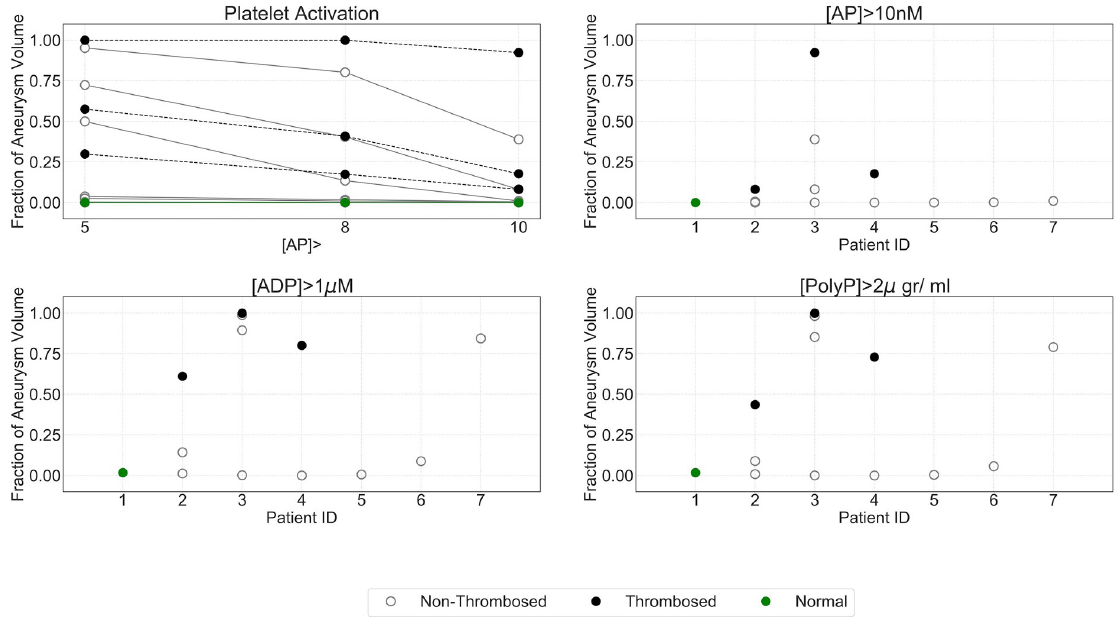
Fig 6. Pro-coagulant environment quantification based on concentration of activated platelets and agonists. a) Changes in fraction of aneurysm volume where [ AP ] > 5, 8, 10 nM; b) fraction of aneurysm volume where [ AP ] > 10 nM. Pro-coagulant environment quantification based on ADP and PolyP critical thresholds. c) Fraction of aneurysm volume where [ ADP ] > [ ADP ] crit ; d) fraction of . Th = confirmed thrombosis, NonTh = non confirmed thrombosis, [AP] = activated platelet aneurysm volume where [ PolyP ] > [ PolyP ] crit